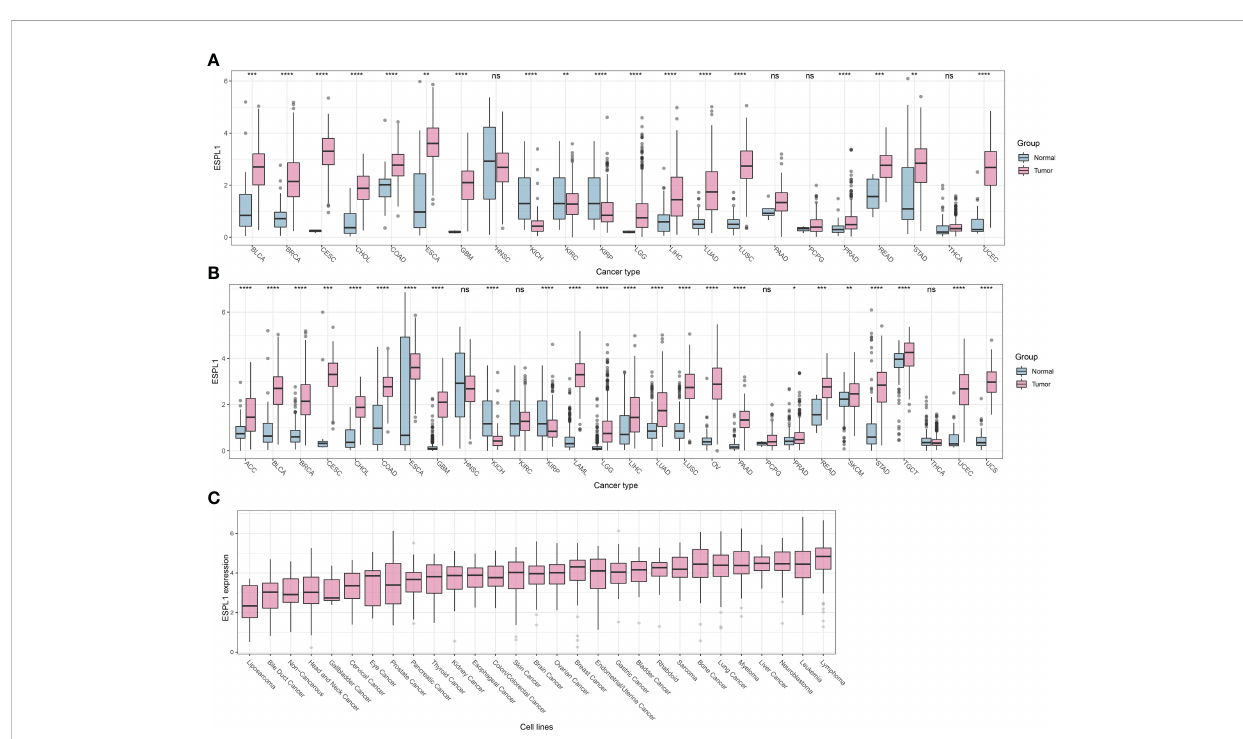
FIGURE 1 ESPL1 is aberrantly expressed in tumor tissue. (A) Expression pro fi le of ESPL1 in TCGA cohorts. (B) Expression analysis of ESPL1 in tumor tissues from TCGA database and matched normal tissues from the GTEx database. (C) Expression of ESPL1 in different types of cell lines. *P<0.05, **P<0.01; ***P<0.001, ****P<0.0001; ns, Not Signi fi cant. GTEx, Data of Genotype-Tissue Expression; TCGA, The Cancer Genome